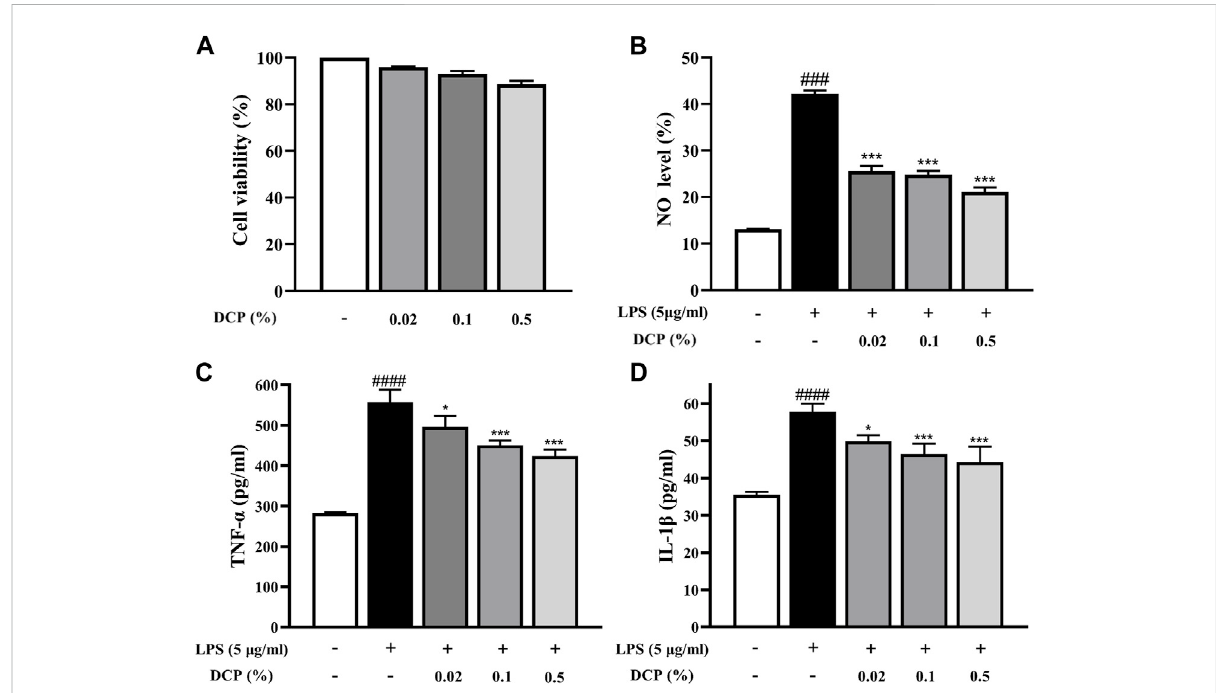
FIGURE 2 Effects of DCP on RAW 264.7 cell viability (A) ;Effects of DCP on the LPS-induced NO production (B) and proin fl ammatory cytokine production in RAW 264.7 cells (C – D) . RAW 264.7 cells were pre-incubated with 5 μ g/ml LPS for 2 h, and then treated with 0.02%, 0.1% and 0.5% DCP for an additional 24 h.Each pointrepresents themean± S.E.M. of3experiments. # p < 0.05, #### p < 0.0001,comparedwith Controlgroup; * p < 0.05, ** p < 0.01, *** p < 0.001 compared with LPS group.